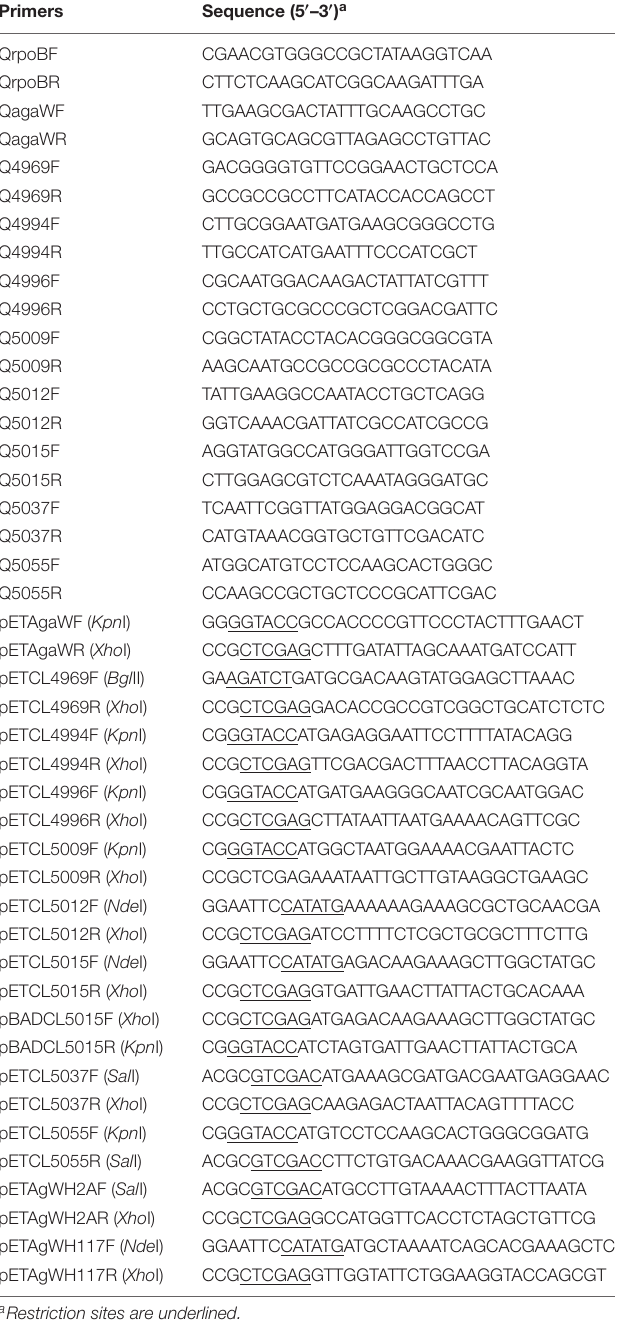
TABLE 1 | Primers used in this